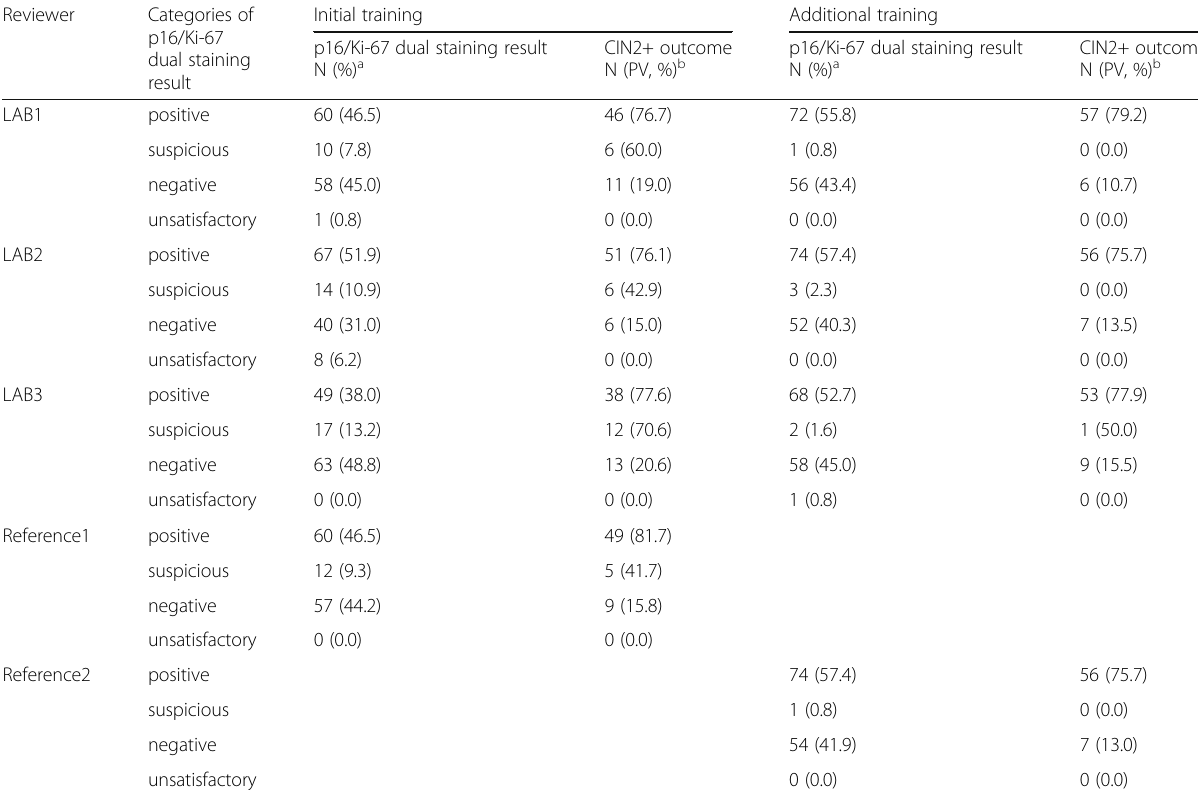
Table 1 p16/Ki-67 study results and CIN2+ outcome for three cytopathology laboratories and references Reviewer